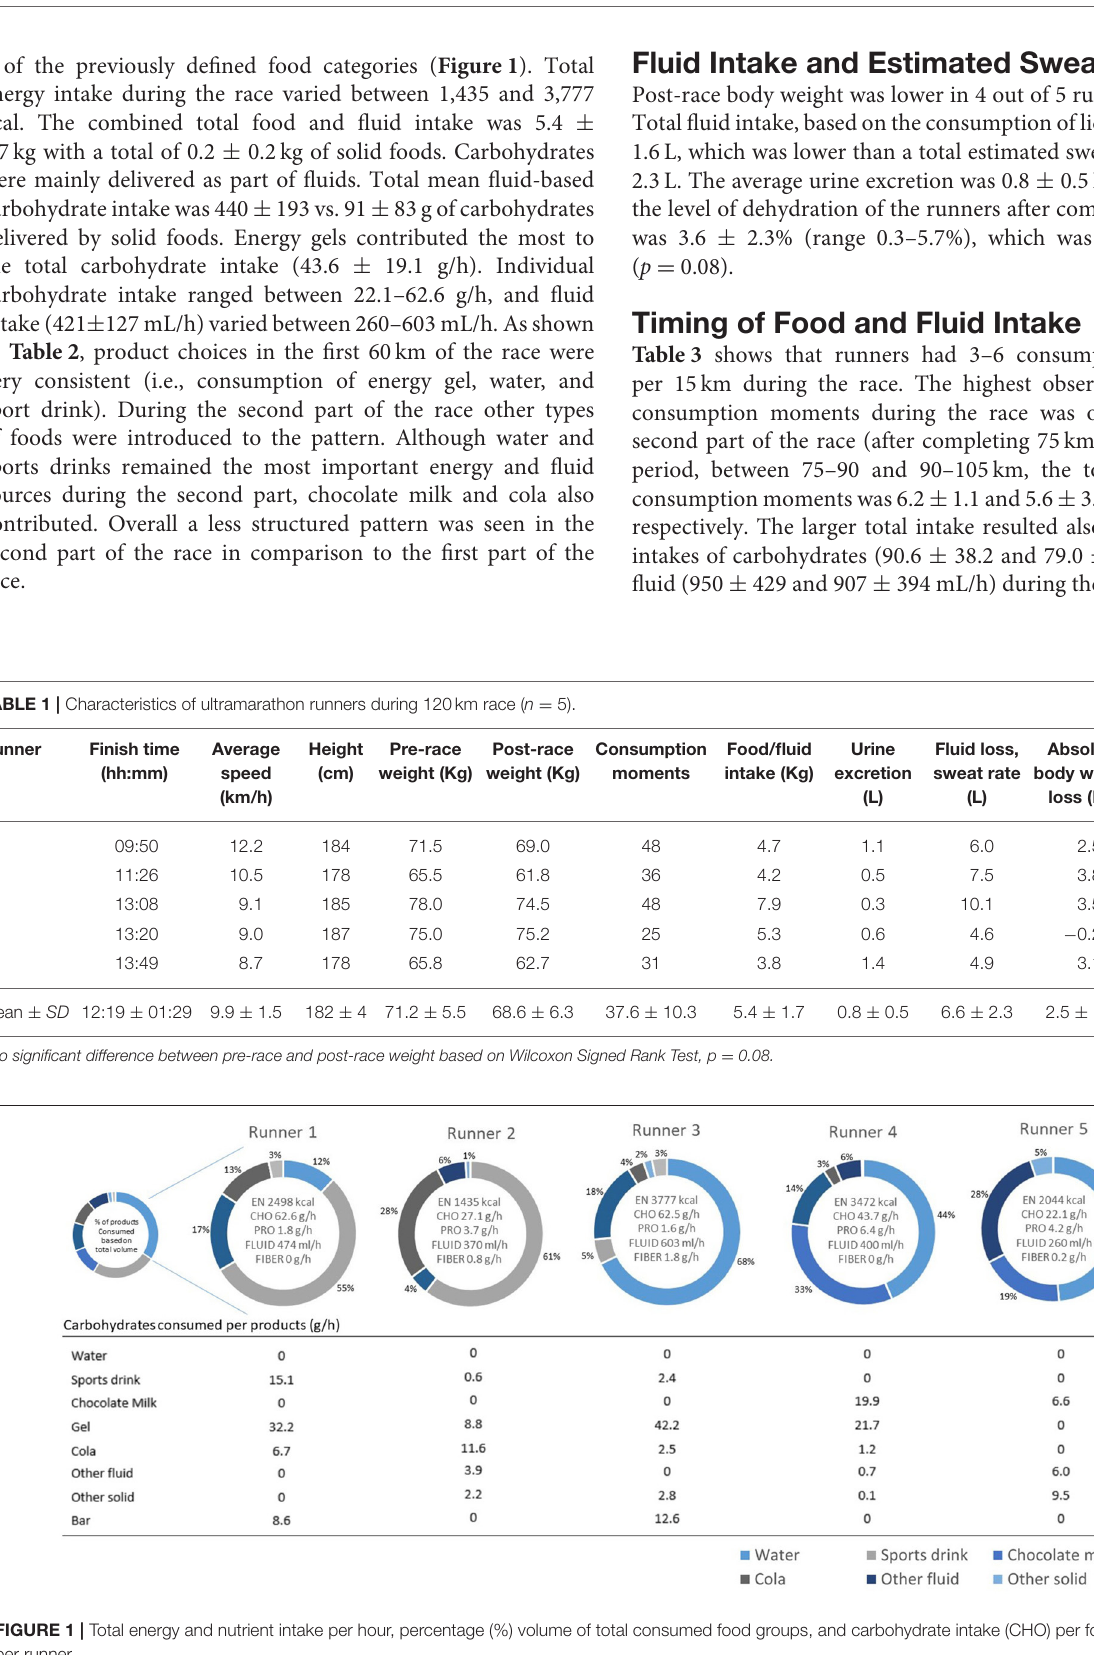
Frontiers in Nutrition |